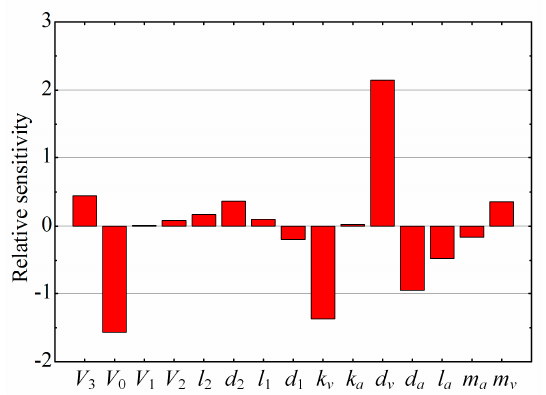
Figure 11. The parametric sensitivity on the oscillation of the variable displacement mechanism.